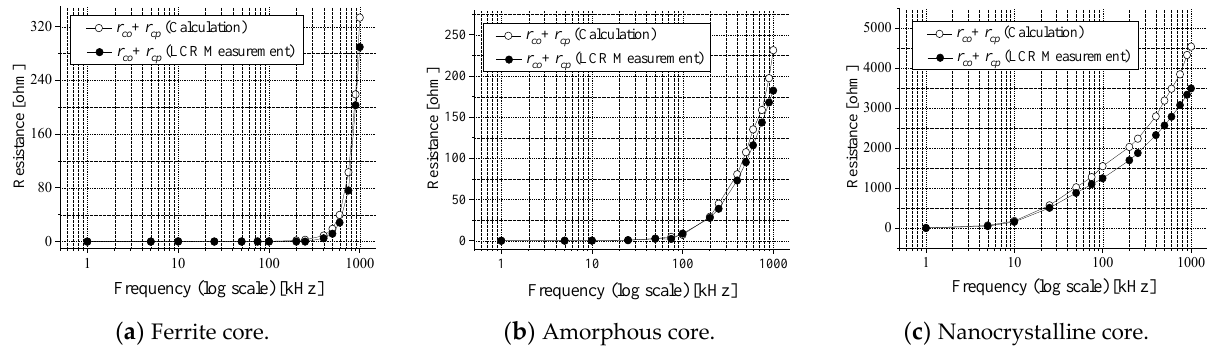
( a ) Ferrite core. ( b ) Amorphous core. ( c ) Nanocrystalline core. Figure 4. Calculated and LCR measurement results of the resistance for three different core materials.